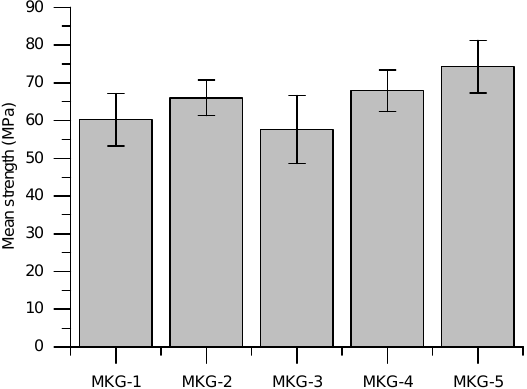
Figure 3. Statistical strengths of the MKG mortars.